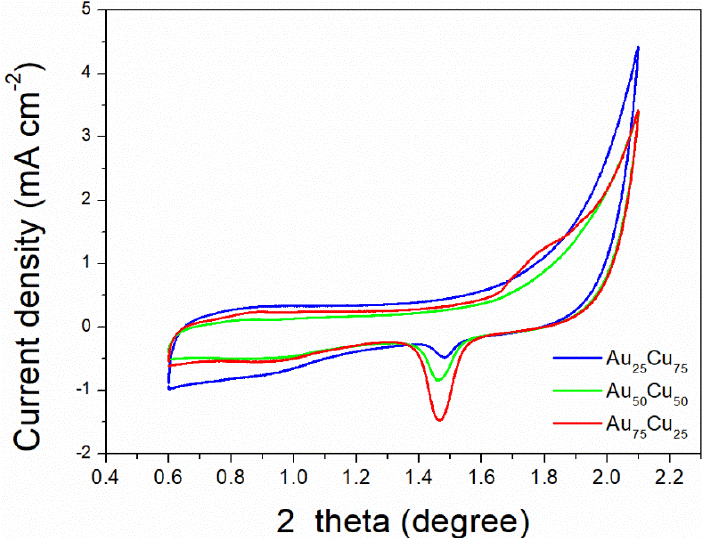
Figure 7. The ECSA of Au 25 Cu 75 /C, Au 50 Cu 50 /C and Au 75 Cu 25 /C. Cyclic voltammograms in 50 mM H 2 SO 4 , scan rate 50 mV s − 1 .